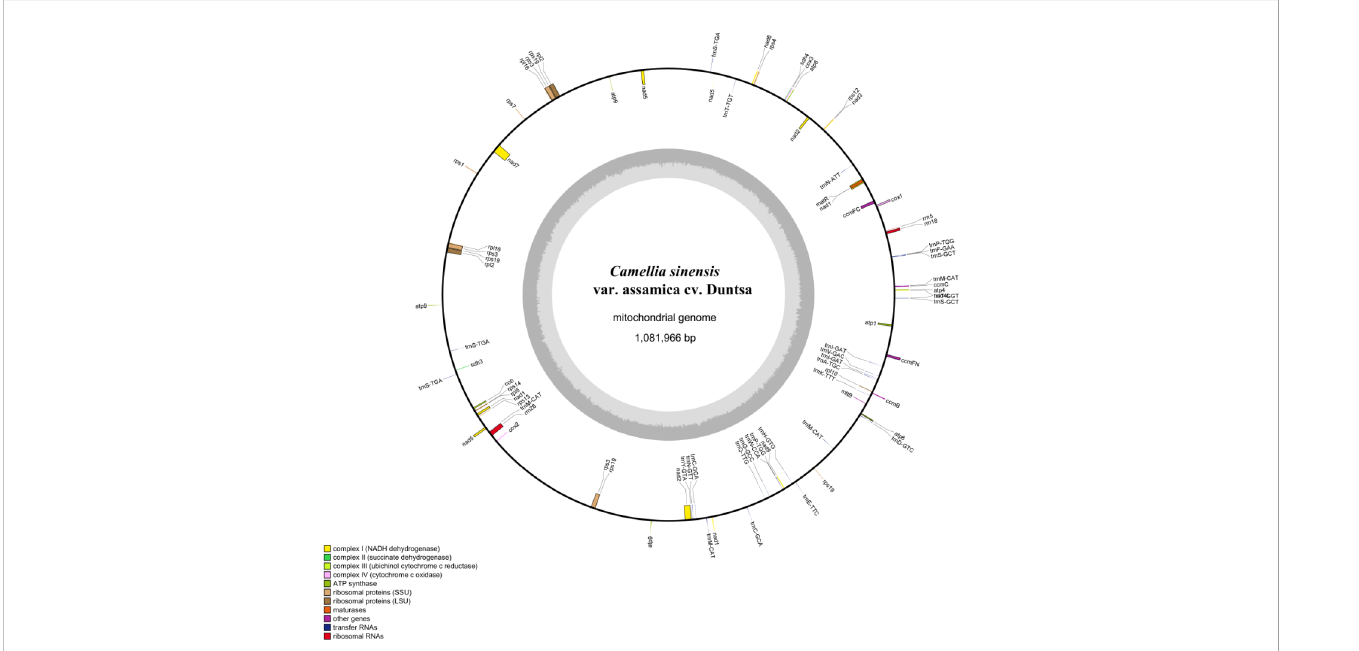
FIGURE 1 C .duntsa mitochondrial genome circular